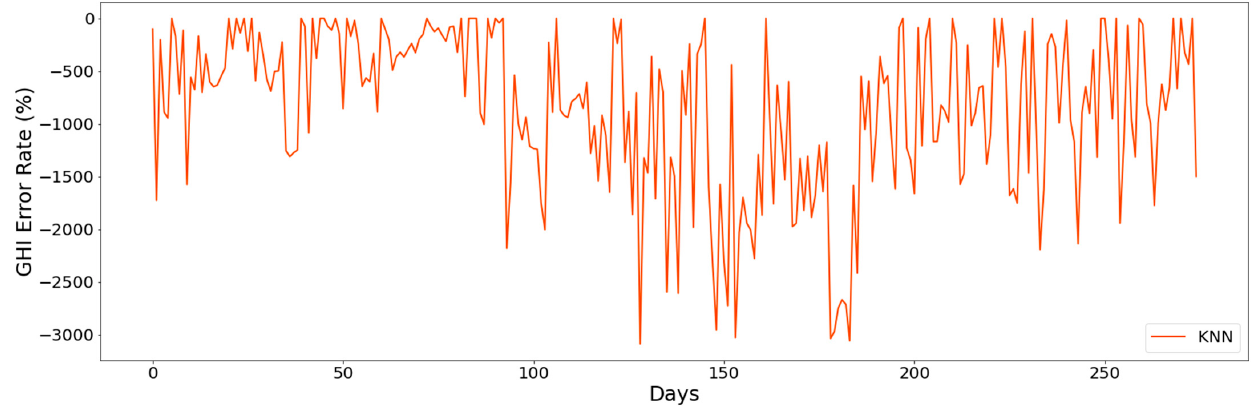
Figure 6. KNN error frequency rate.